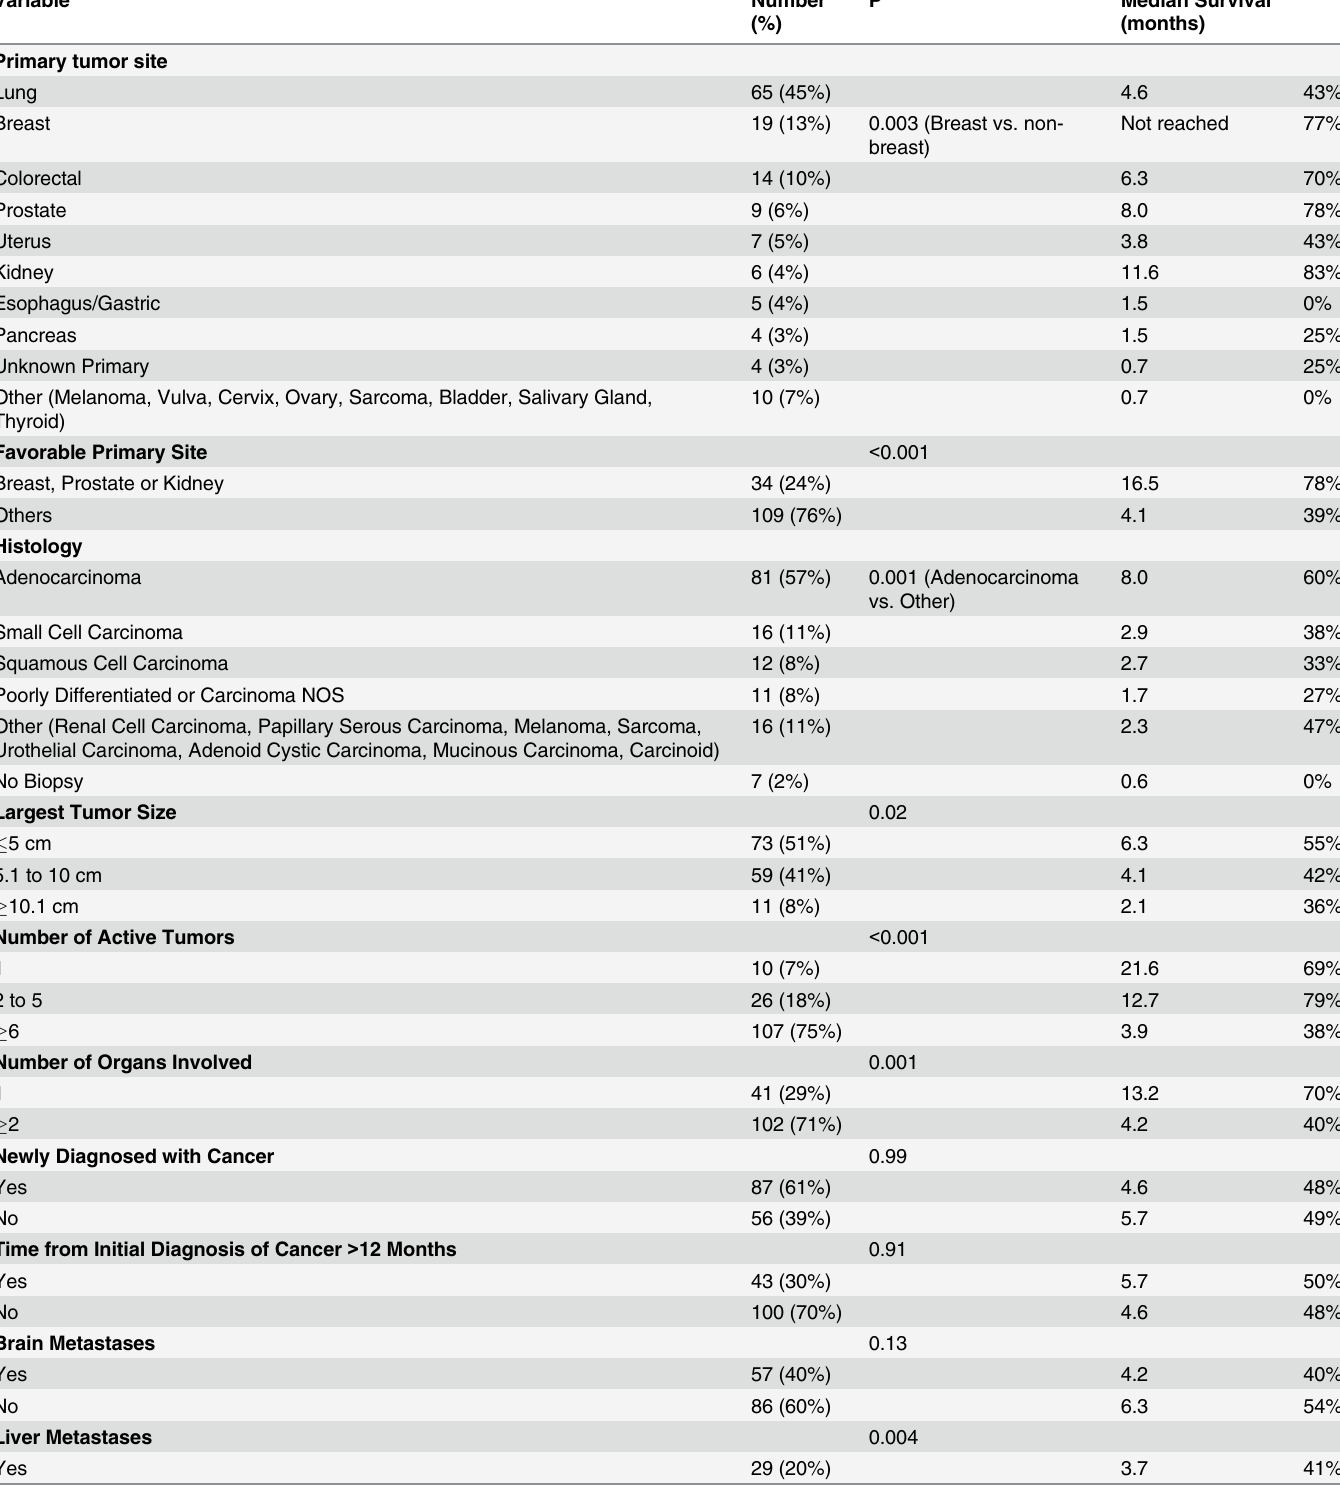
Table 2. Univariate analysis of tumor characteristics on overall survival of patients with advanced